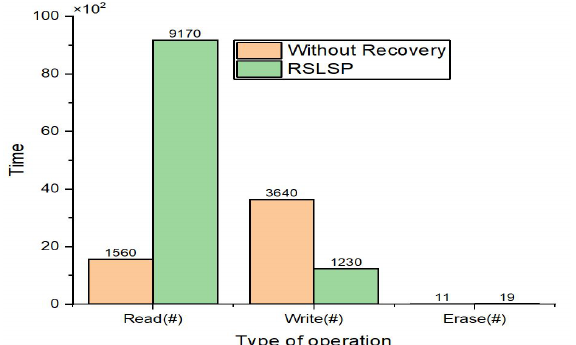
Figure 9. Results for pattern